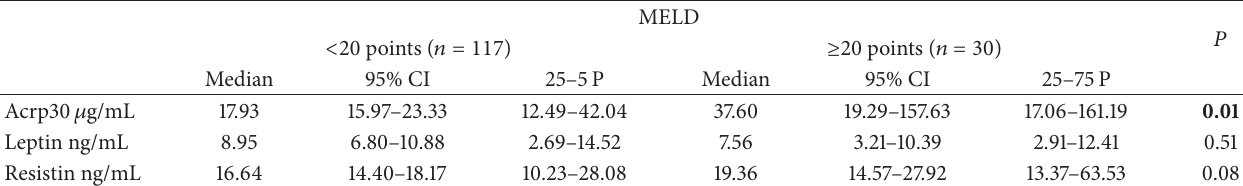
Table 7: Serum adipokine levels in patients with ALD according to the MELD score.